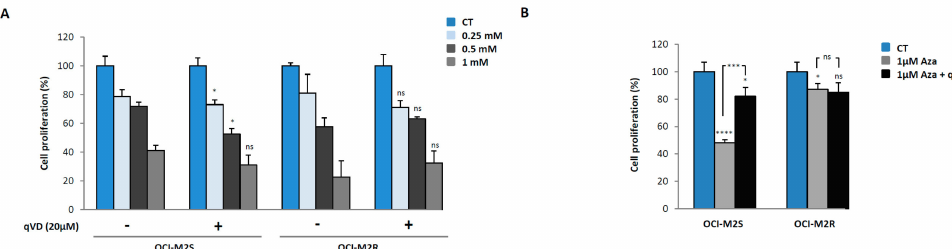
Figure 2. The anti-leukemic e ff ects of Aca are mediated by caspase independent mechanisms ( A ) OCI-M2S and OCI-M2R cells (0.5 × 10 6 cells / mL) were treated with increasing concentrations of Aca for 48 h at 37 ◦ C, in the presence or in the absence of 20 µ M Z-VAD-fmk, a pan-caspase inhibitor. Cell metabolism was measured using the XTT assay as described in Materials and Methods section. ( B ) OCI-M2S and OCI-M2R cells (0.5 × 10 6 cells / mL) were treated with 1 µ M of Aza for 48 h at 37 ◦